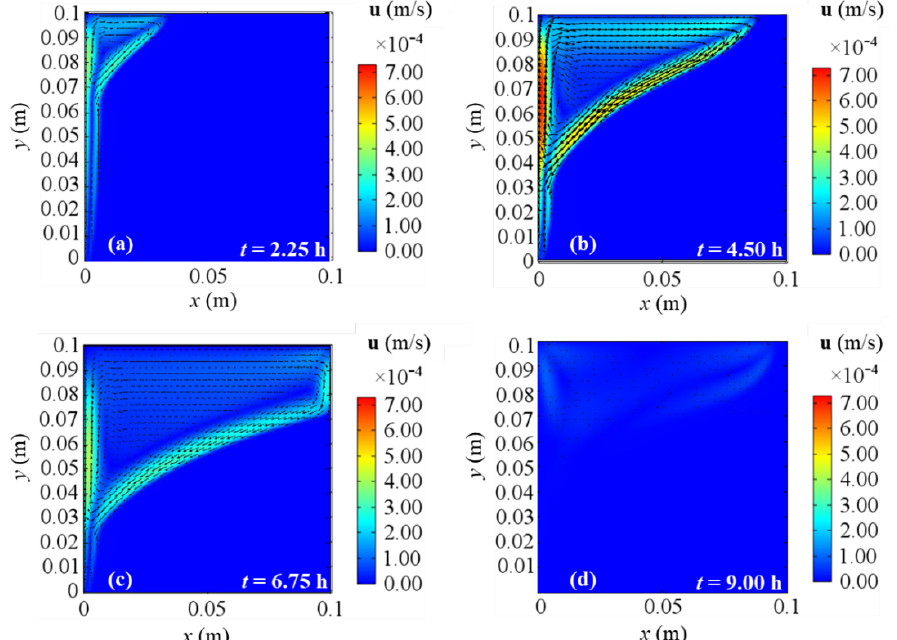
Figure 13. Velocity fields for 2D model with natural convection and BC 4 at different evaluation times: ( a ) after 2.25 h; ( b ) after 4.50 h; ( c ) after 6.75 h; ( d ) after 9.00 h from the simulation beginning respectively.